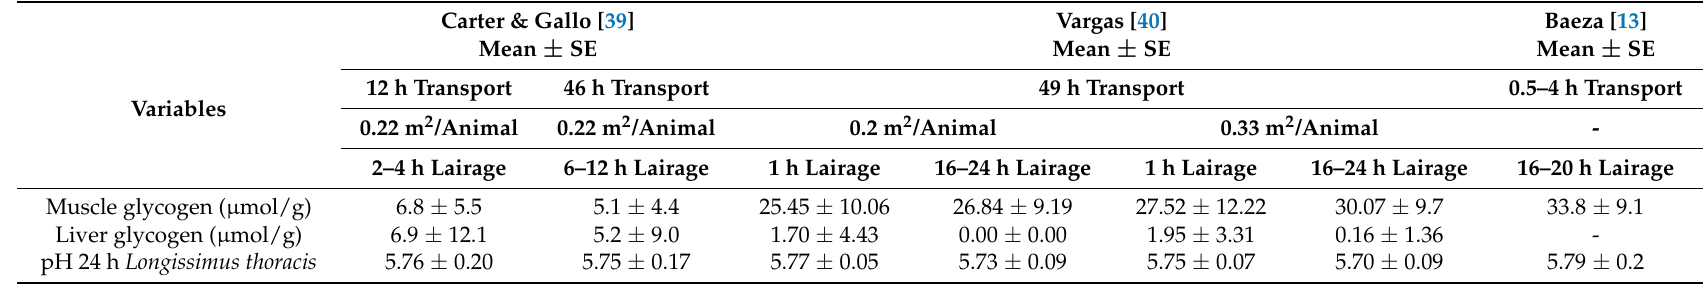
Table 3. Muscle and liver glycogen concentrations, and pH at 24 h postmortem in Longissimus thoracis muscle of lambs in different Chilean studies.